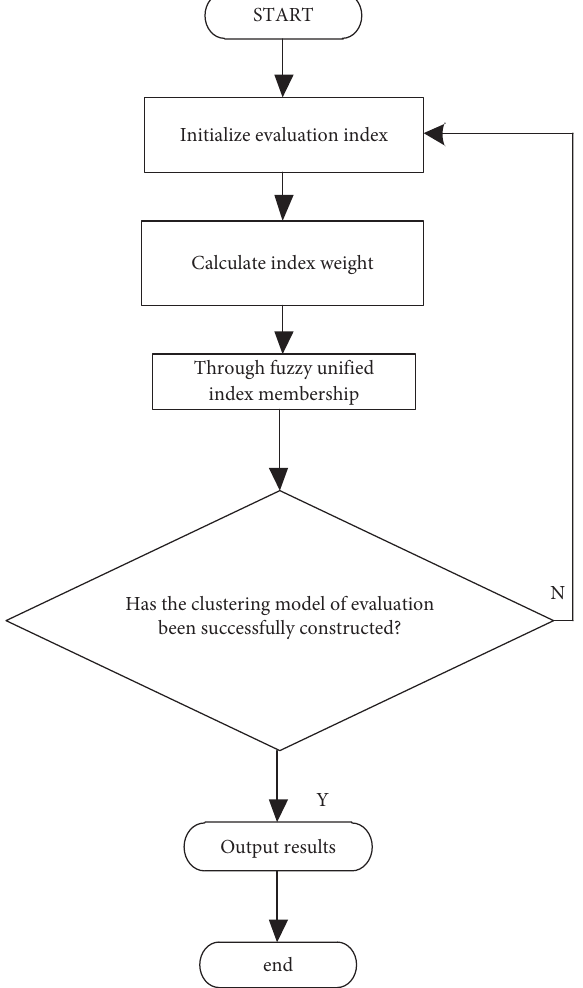
Figure 3: Design process of labor legal effectiveness evaluation algorithm against gender